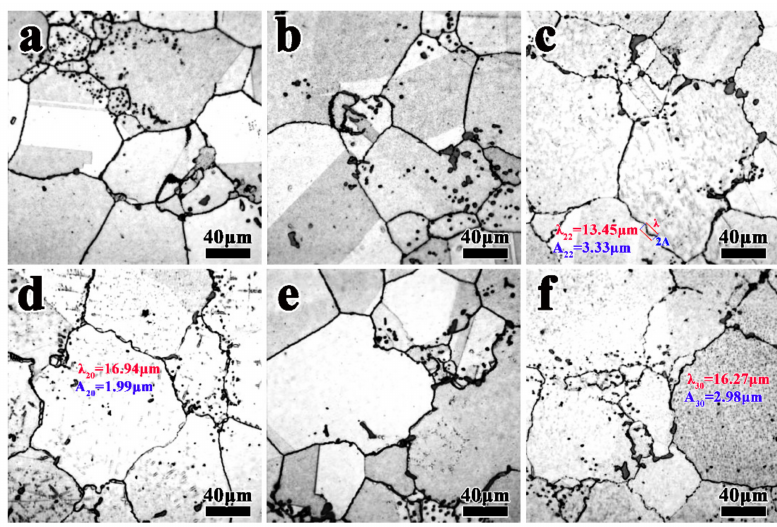
Figure 6. The formation of serrated grain boundaries under different heat treatment conditions: ( a ) T1; ( b ) T2; ( c ) T3; ( d ) T4; ( e ) T5; ( f )